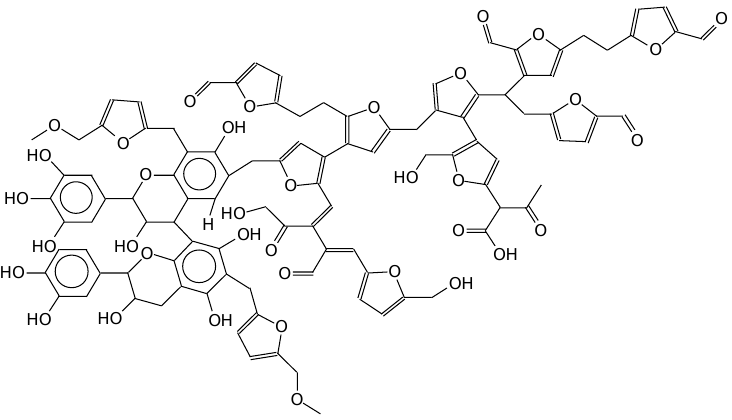
Scheme 10. Example of higher molecular weight structure in the foams derived from the reaction of humins higher and lower molecular weight oligomers with flavonoid oligomers of the tannin.